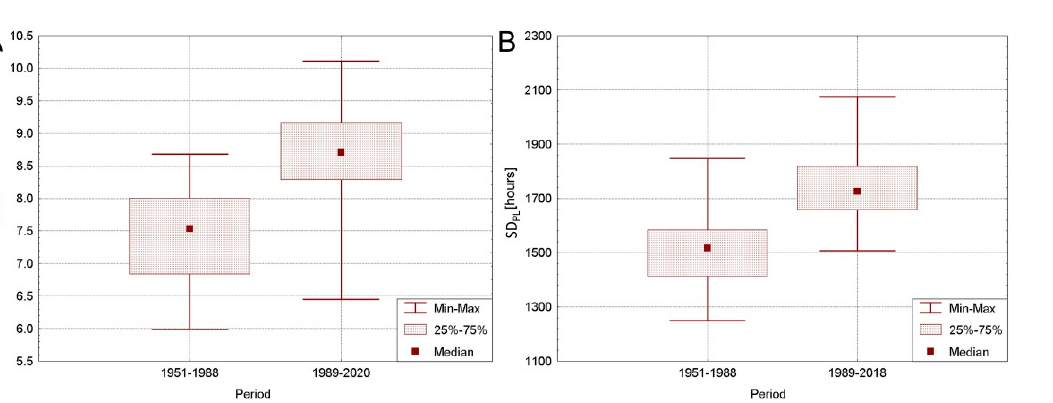
Figure 4. Ranges of variability of the annual area air temperature (T PL ) ( A ) and sunshine duration (SD PL ) ( B ) in Poland in sub-periods 1951–1988 and 1989–2020.